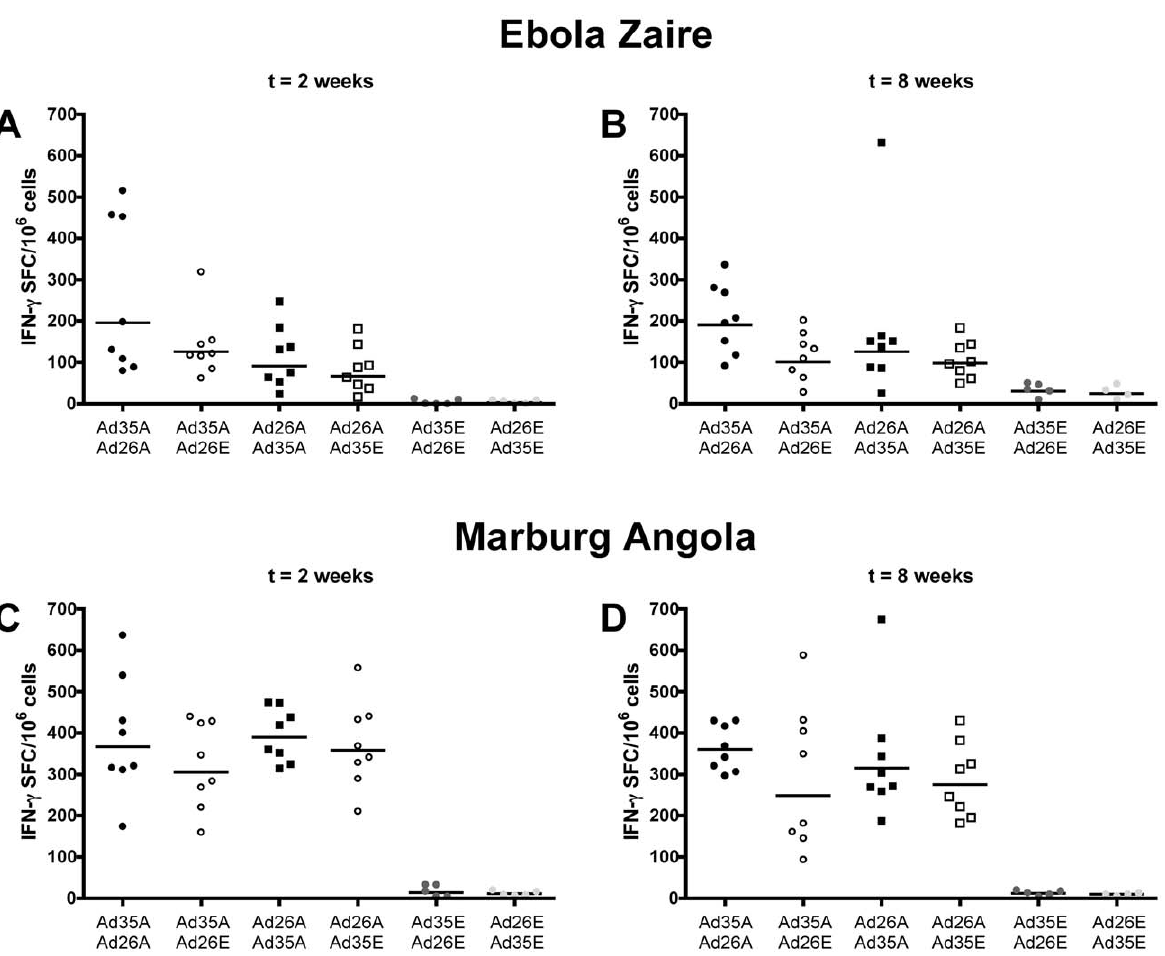
Figure 5. Enhanced filovirus specific cellular immune response of a rAd26/rAd35 prime-boost regimen. Filovirus specific cellular immune response was detected by ELISPOT after stimulation with peptide pools spanning the entire glycoprotein. Splenocytes were isolated from groups of mice at two or eight weeks post boost vaccination with 10 10 vp of with vectors coding for Ebola Zaire (A and B), Marburg Angola (C and D), or as control for prime only with a no-antigen coding control vector. The black filled circles represent the group of Ad35.Ebo(Z) or Ad35.Mar(A) primed and Ad26.Ebo(Z) or Ad26.Mar(A) boosted animals; black open circles represent the Ad35.Ebo(Z) or Ad35.Mar(A) primed animals which received the no-antigen coding control vector Ad26.empty as boost. The black filled squares represent the group of Ad26.Ebo(Z) or Ad26.Mar(A) primed and Ad35.Ebo(Z) or Ad35.Mar(A) boosted animals; black open squares represent the Ad26.Ebo(Z) or Ad26.Mar(A) primed animals which received the no-antigen coding control vector Ad35.empty as boost. The dark grey circles represent the control animal group receiving Ad35.empty for prime and Ad26.empty as boost and the light grey circles the animal group receiving Ad26.empty for prime and Ad35.empty as boost. The bar denote the geometric mean of the responsive cells of eight mice (five for the control